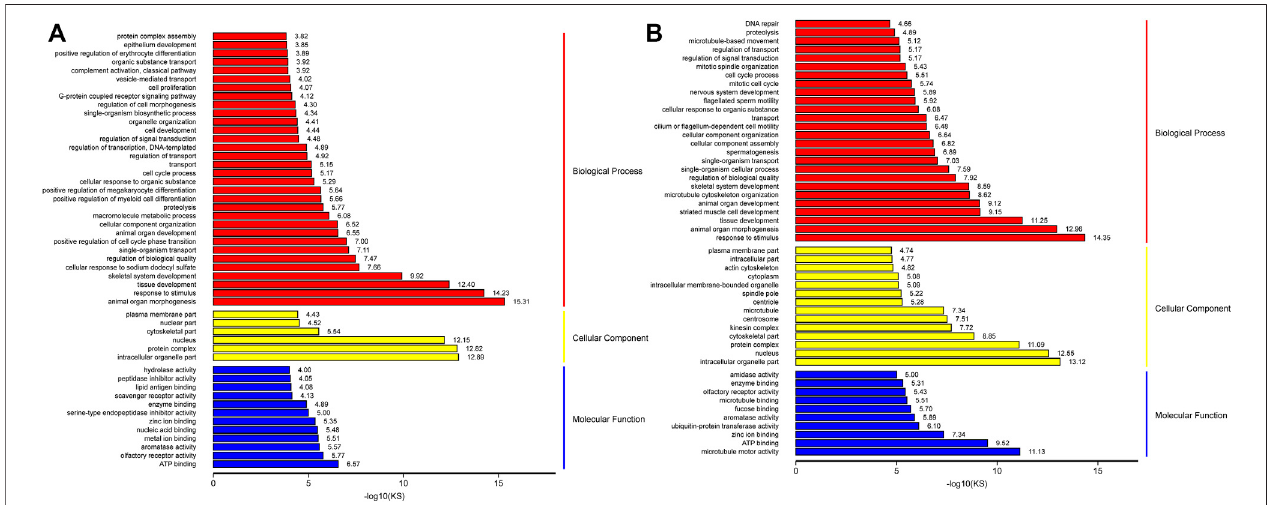
FIGURE 5 | GO analysis of up-regulation genes in M3_vs_M0 analysis group (A) and M6_vs_M3 analysis group (B) .